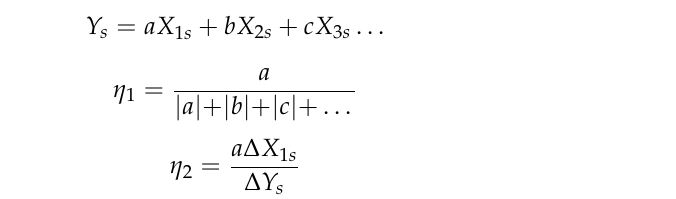
Figure 2. Technology roadmap.